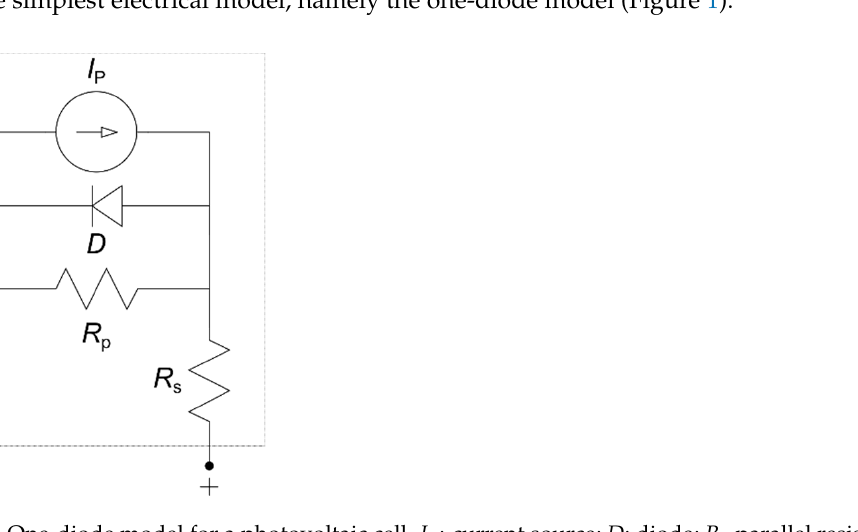
Figure 1. One-diode model for a photovoltaic cell. I P : current source; D : diode; R p parallel resistor; R s : series resistor.